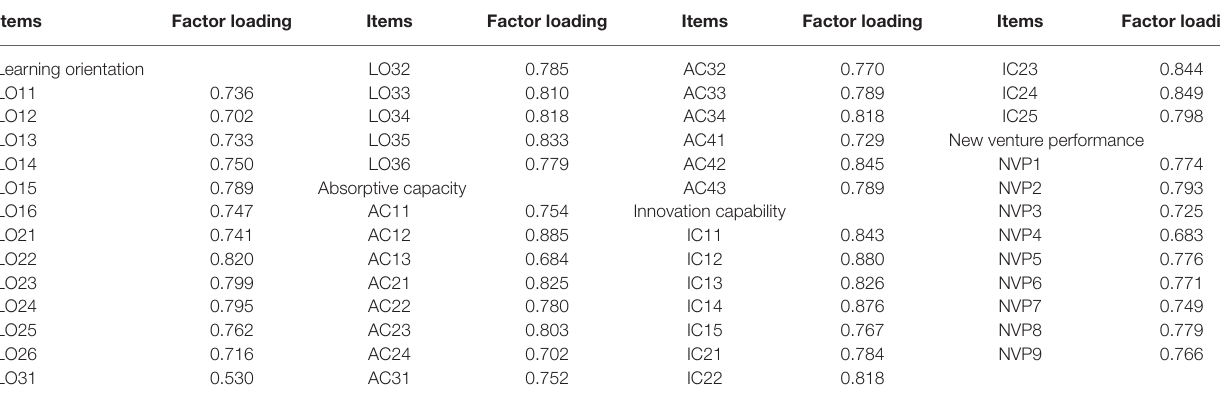
TABLE 2 | Results of the confirmatory factor analysis. Items Factor loading Items Items Items Factor loading Learning orientation